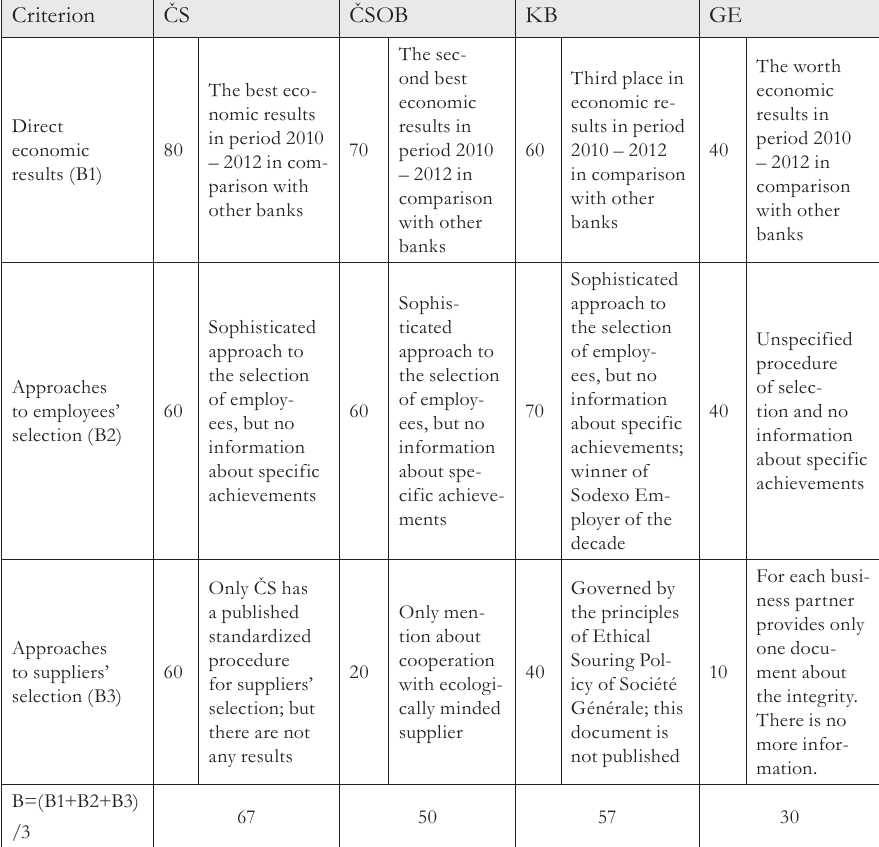
Tab. 2 - Evaluation criteria in the area of direct economic effects on a community.